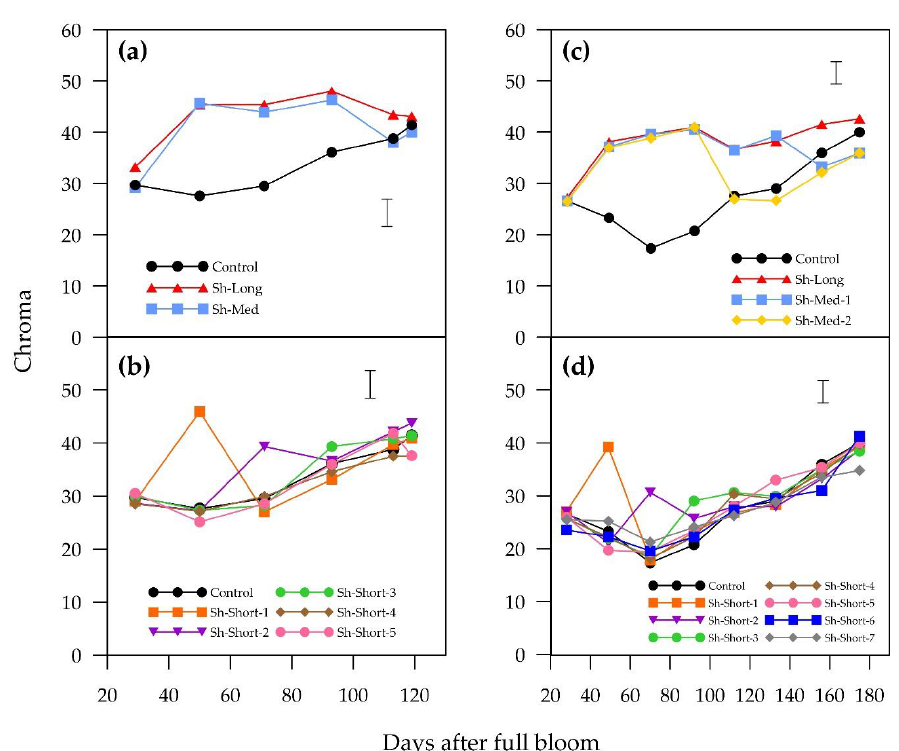
Figure 5. Temporal patterns of change in means of chroma for “ANP-0118” ( a = long and medium shading treatments; b = short shading treatments) and “ANP-0131” ( c = long and medium shading treatments; d = short shading treatments). The control is displayed alongside treatments. Error bar represents Fisher’s LSD at 5% level of significance.